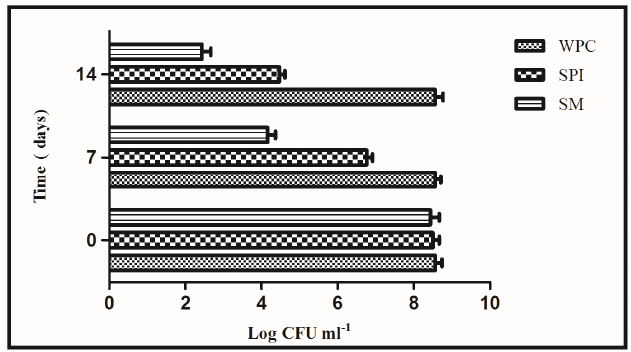
Figure 2. Viability of L. rhamnosus GG in WPC, SPI, and SM supplemented sea buckthorn juice during cold storage. The data presented are means of triplicate experiments ± standard deviation.